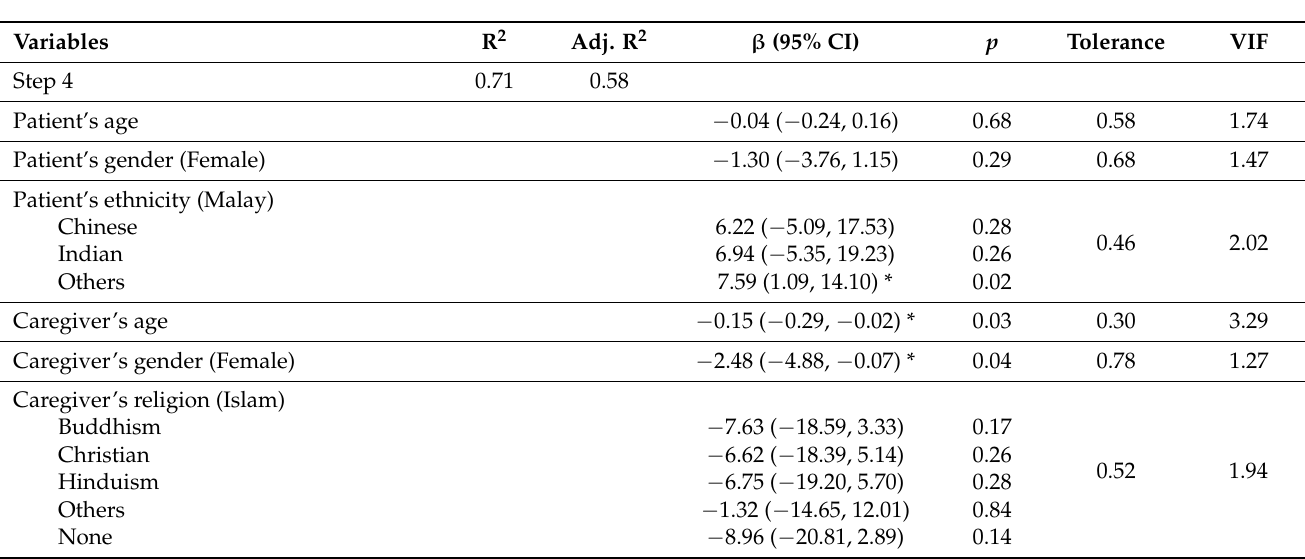
Table 11. Hierarchical General Linear Model Analysis for Predictors of Depressive Symptoms in Caregivers of